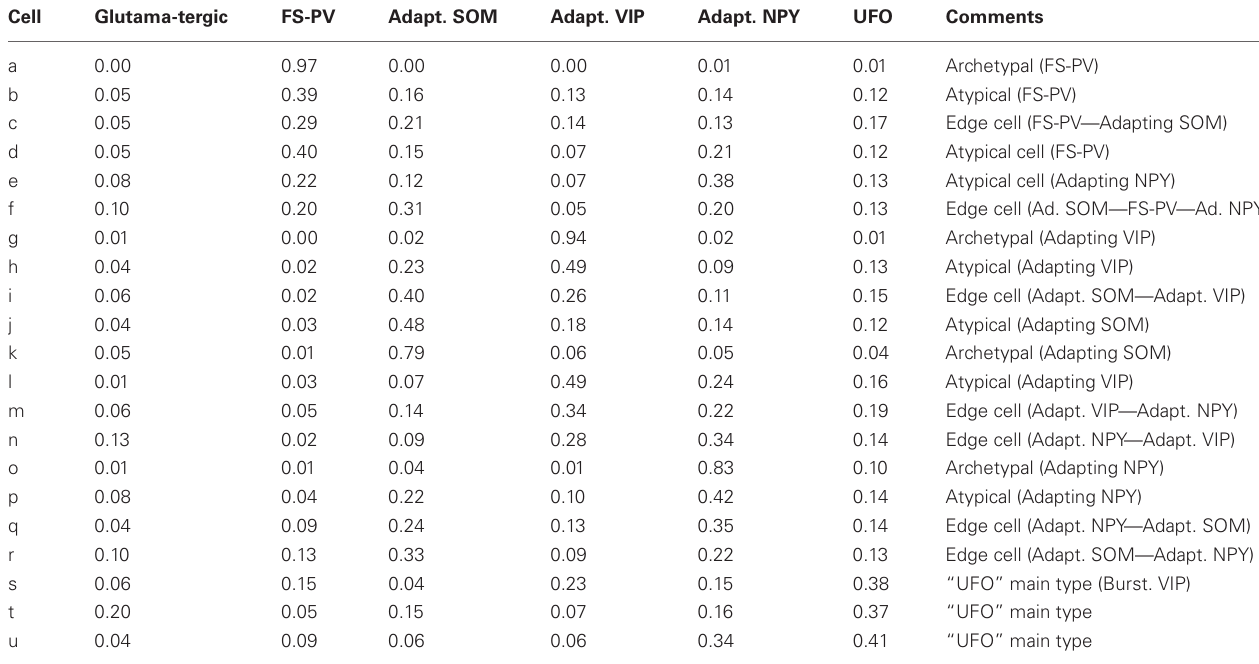
Table 6 | Membership values of cells in the sequences of Figures 2, 3, and